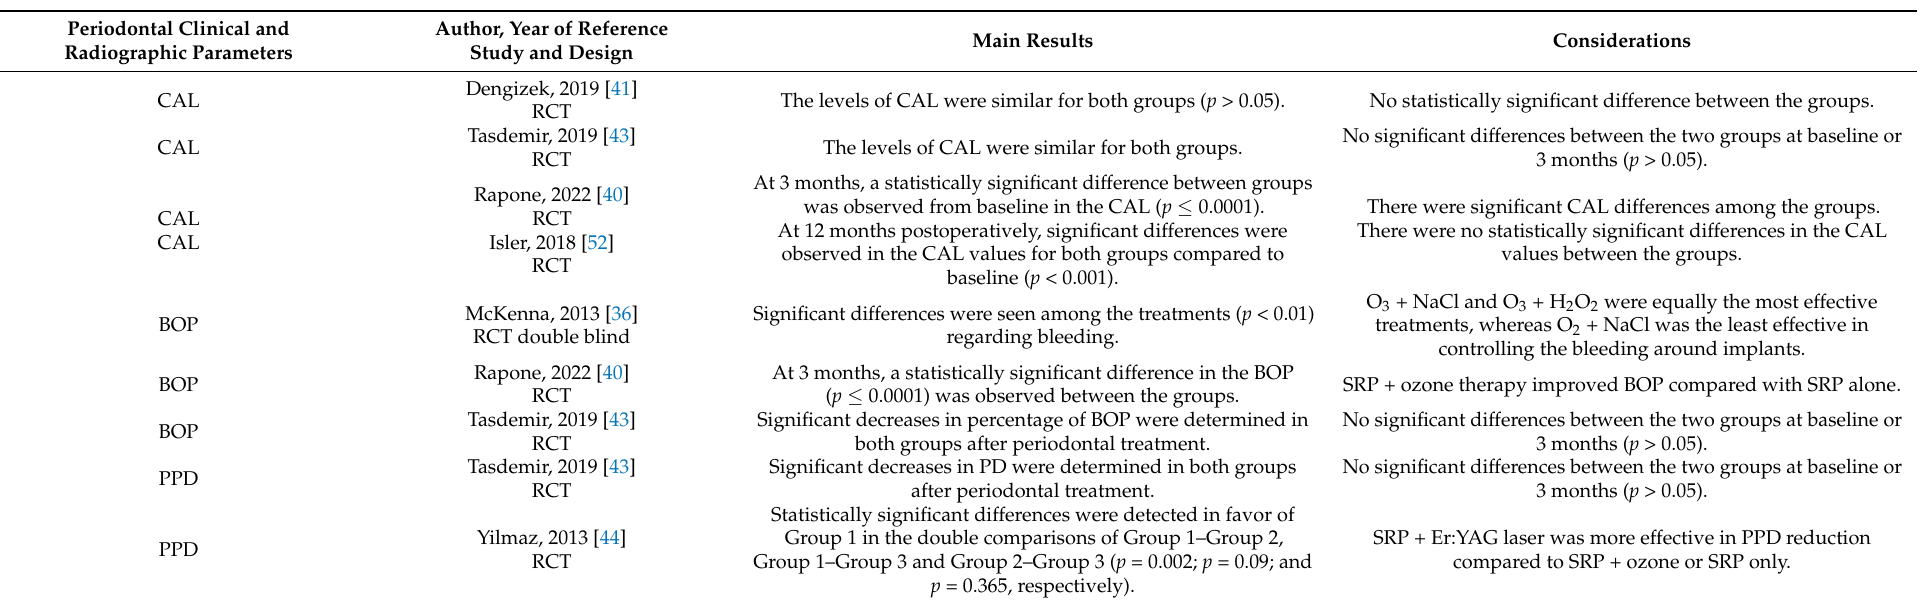
Table 3. Characteristics of the periodontal clinical, radiographic and inflammatory parameters for gaseous ozone, including clinical attachment loss (CAL), probing depth (PPD), bleeding on probing (BoP), plaque index (PI), gingival index (GI), marginal bone levels (MBL) and periodontal treatment with Scaling and Root Planing